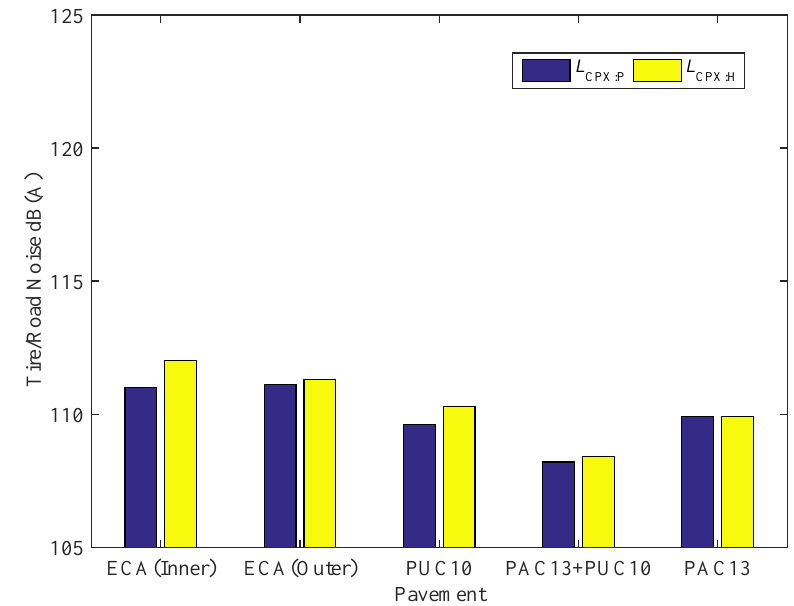
Figure 5. Tire/road noise for different pavements at 60